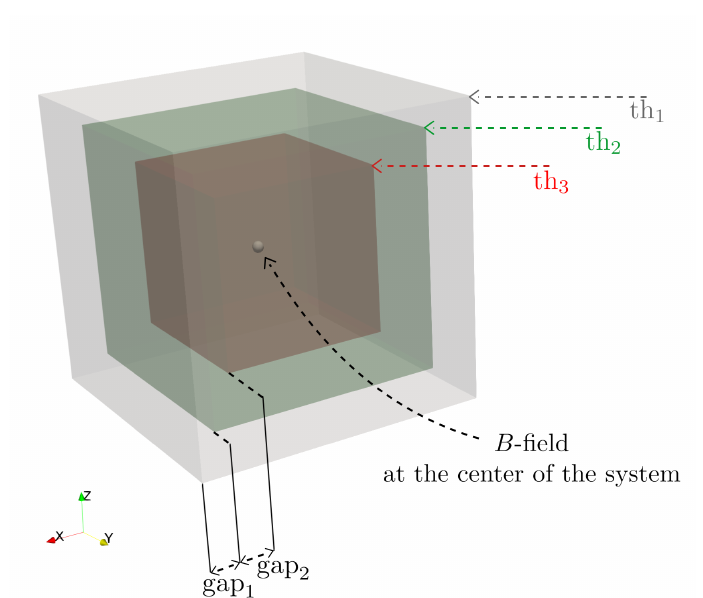
Figure 8. Geometrical parameters of the optimization